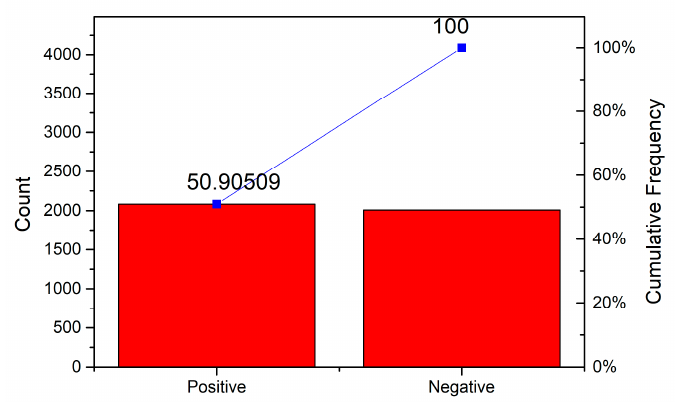
Figure 3. Percentage ratio of positive and negative emotions tweets for training